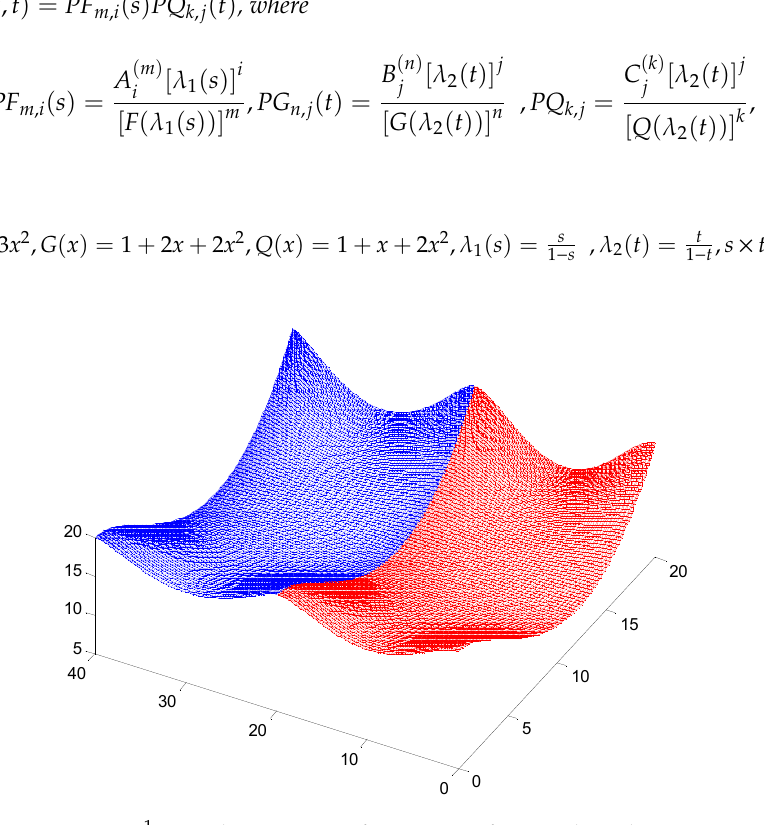
Figure 4. G 1 smooth continuity of two S- λ surfaces in the u direction.